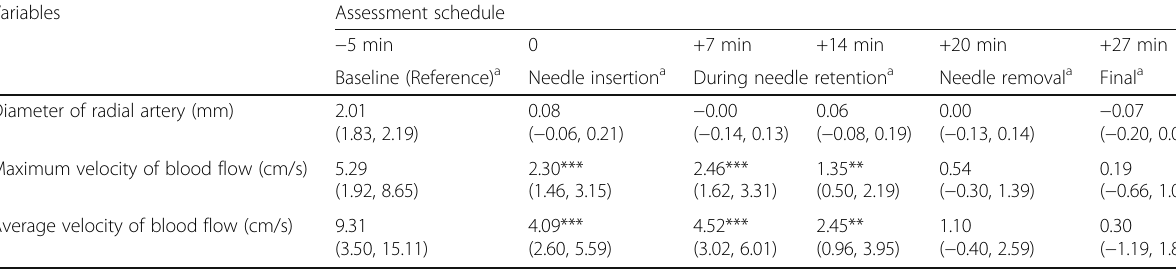
Table 5 Results of assessments on the variables from radial artery